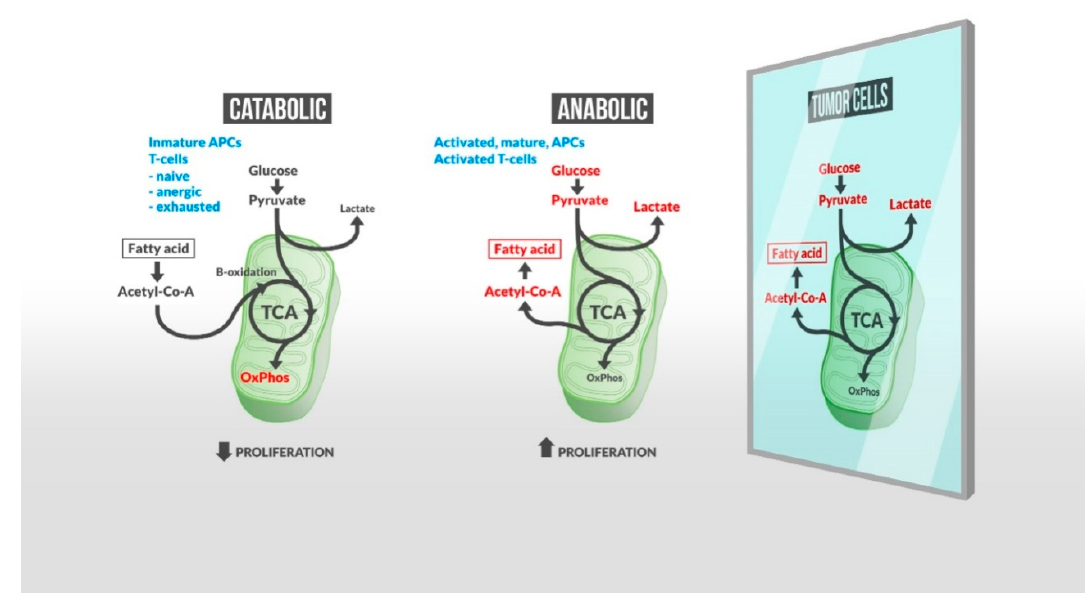
Figure 1. A metabolic shift is required by immune cells for them to respond actively to tumor cells. Inactive immune cells rely on oxidative phosphorylation (OxPhos) and fatty acid (FA) oxidation (left), while activated and responsive cells increase glucose uptake/glycolysis, resulting in an increased FA synthesis and lactate production (central panel). Lipogenesis, required for a robust cell proliferation, also characterizes tumor cell metabolism (right). Therefore, an untargeted lipid-based treatment to fuel effector immune cells may produce self-defeating effects inducing tumor cell growth. Many other lipid intermediates regulate inflammation, and exogenous lipids such as gut microbiota-derived short chain fatty acids (SCFAs) may impact the host immune response to tumor cells. Together, these findings indicate (1) the exhaustive regulation required to maintain immunity balance in the presence of tumor cells, and (2) the essential role of a large variety of lipids in this control. New precise lipidomic-based strategies may enhance therapeutic targeting and improve the capacity of existing immunotherapies to control tumor